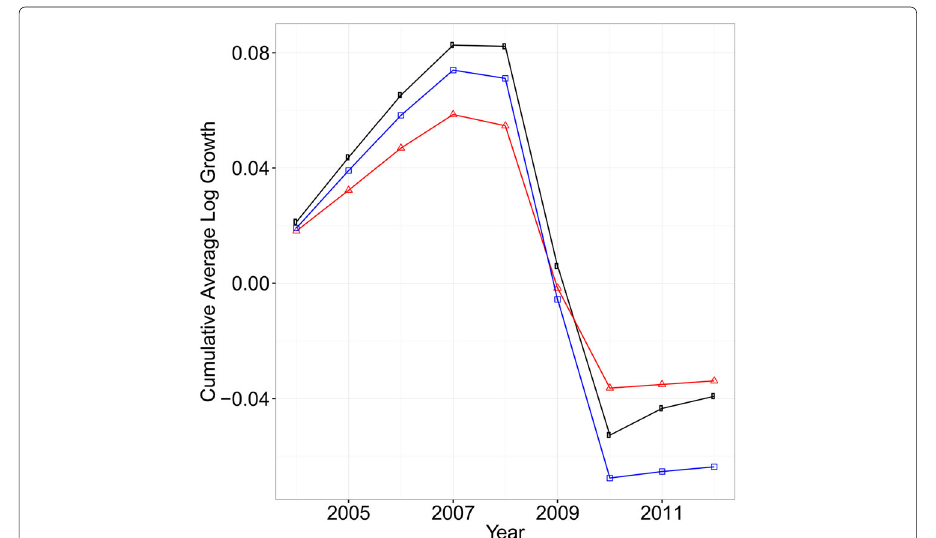
Fig. 7 Time series of cumulative average log growth rate ( blackcircles ), cumulative average shocks for individual firms ( redtriangles ) and simulated average log growth rate assuming that there was no link renewal ( bluesquare ) for years 2004 to